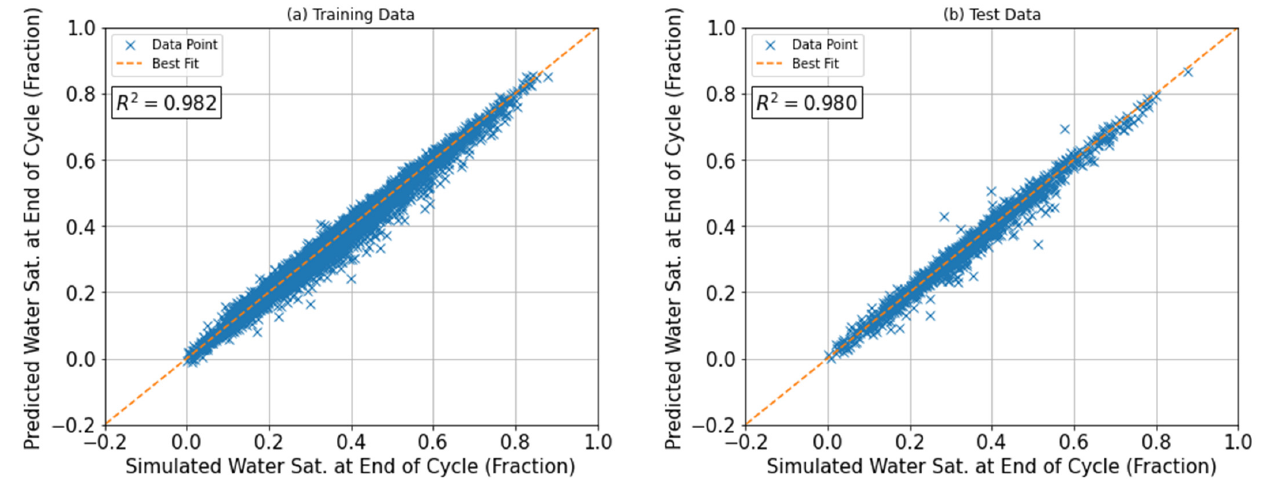
Figure 16. Predicted and simulated plot of ( a ) training data and ( b ) testing data for reservoir water saturation at the end of the cycle—neural network model.